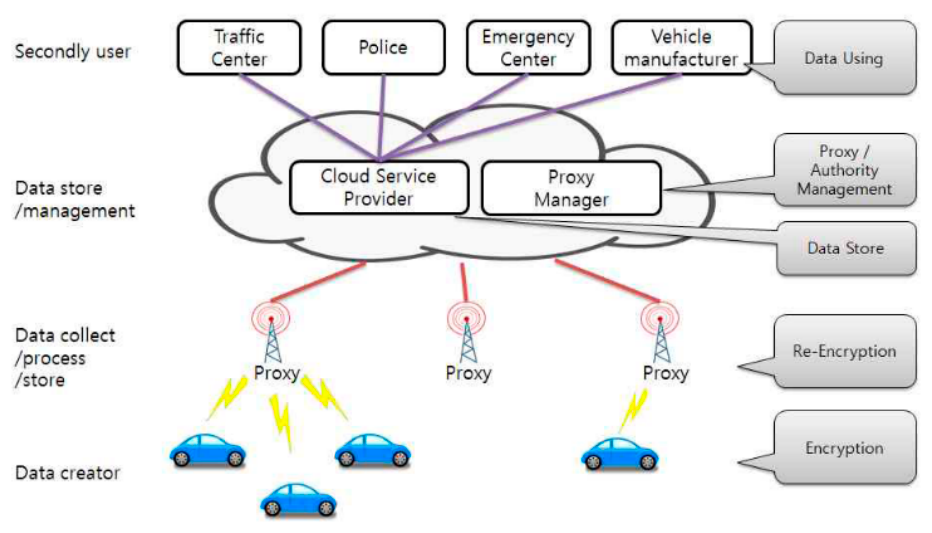
Figure 4. Network model of the proposed system.